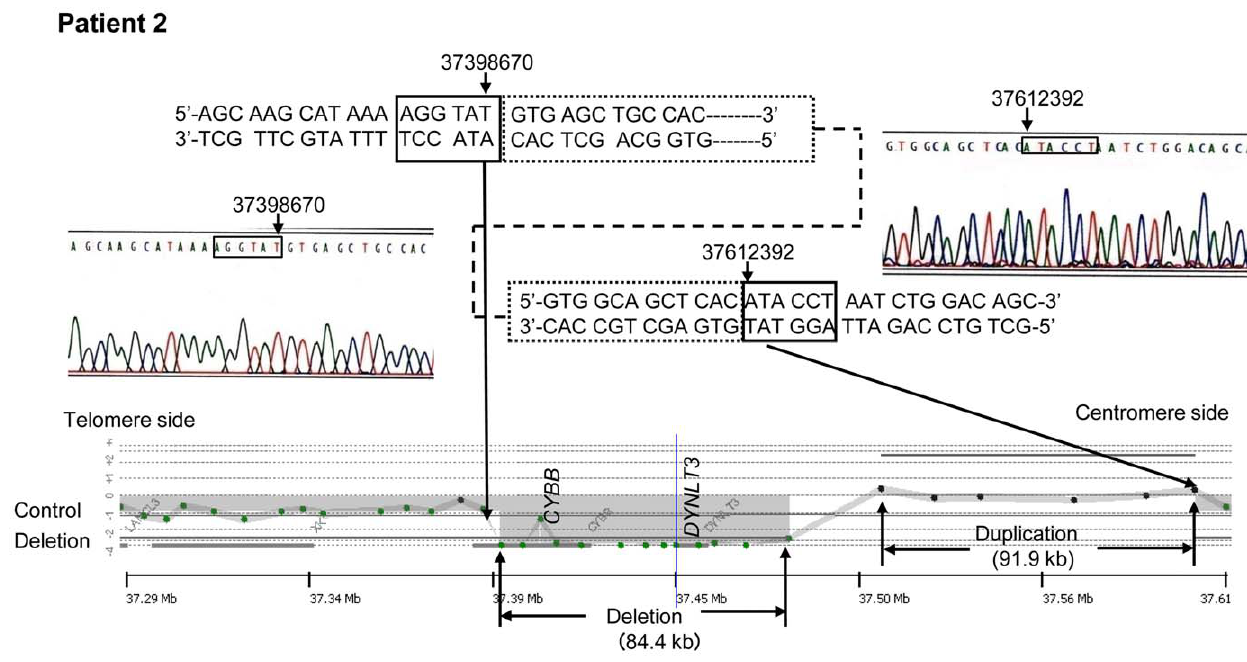
Figure 3. The Results of aCGH and Direct Sequence Analysis Spanning the Deletion Breakpoints in Patient 2. A female’s DNA was used for the control. According to aCGH, the deletion site was 84.4 kbp and the duplication site 91.9 kb. According to the DNA walking analysis by PCR, a breakpoint was located at 37398670 of CYBB intron 2. Furthermore, six bases of the gene at 37612392 (UCSC hg17 May.2004) of ATACCT were bound inverted at the breakpoint, and complex structural abnormalities showing gene deletions on the inner side and duplication of the inverted part were observed.